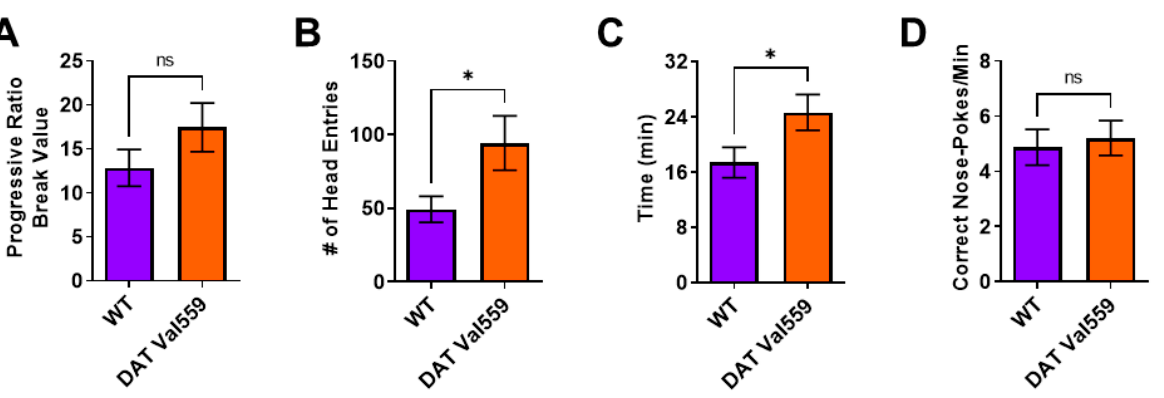
Figure 2. DAT Val559 males show elevated reward seeking phenotypes during devalued progressive ratio. The progressive ratio paradigm was performed in WT ( n = 22) and DAT Val559 ( n = 21) males following reward devaluation. ( A ) Progressive ratio break point. ( B ) Head entries into the reward delivery magazine. ( C ) Experimental session length. ( D ) Response rate. Data were analyzed by two-tailed Student’s t -test. * p < 0.05. ns = not significant. Data are presented as mean ± SEM.